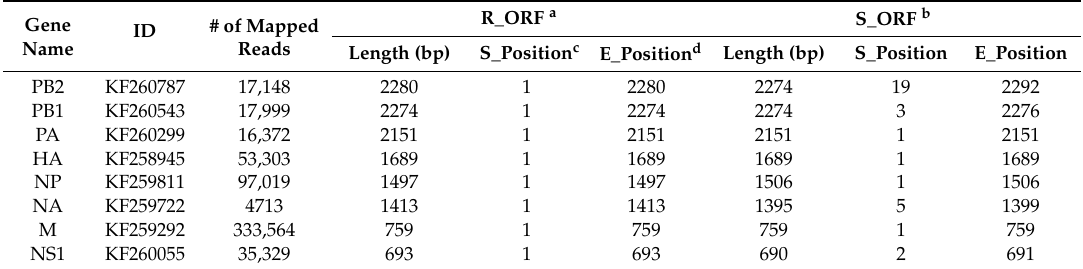
Table 1. Genomic sequence of A / wild duck / Korea / K102 / 2018 (H2N9) obtained by